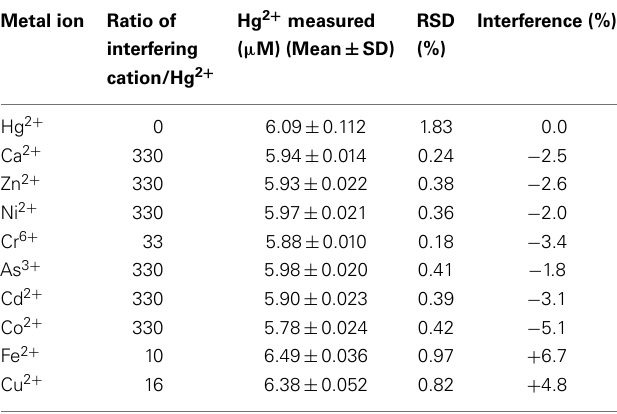
Table 2 | Interference study of other metal ions on the DPSV measurement of 6.0 µ M Hg 2 + using po-Gr/PEDOT:PSS-modified GCE . Metal ion Ratio of